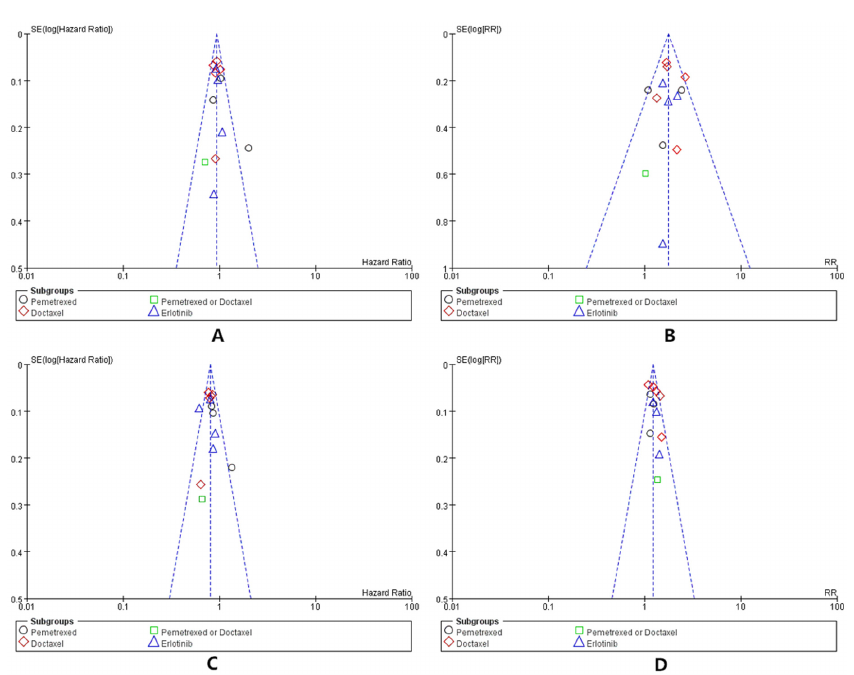
Fig 5. Qualitative analysis of publication bias: Funnel plot of included studies for all outcome. (A) OS, (B) ORR, (C) PFS and (D)